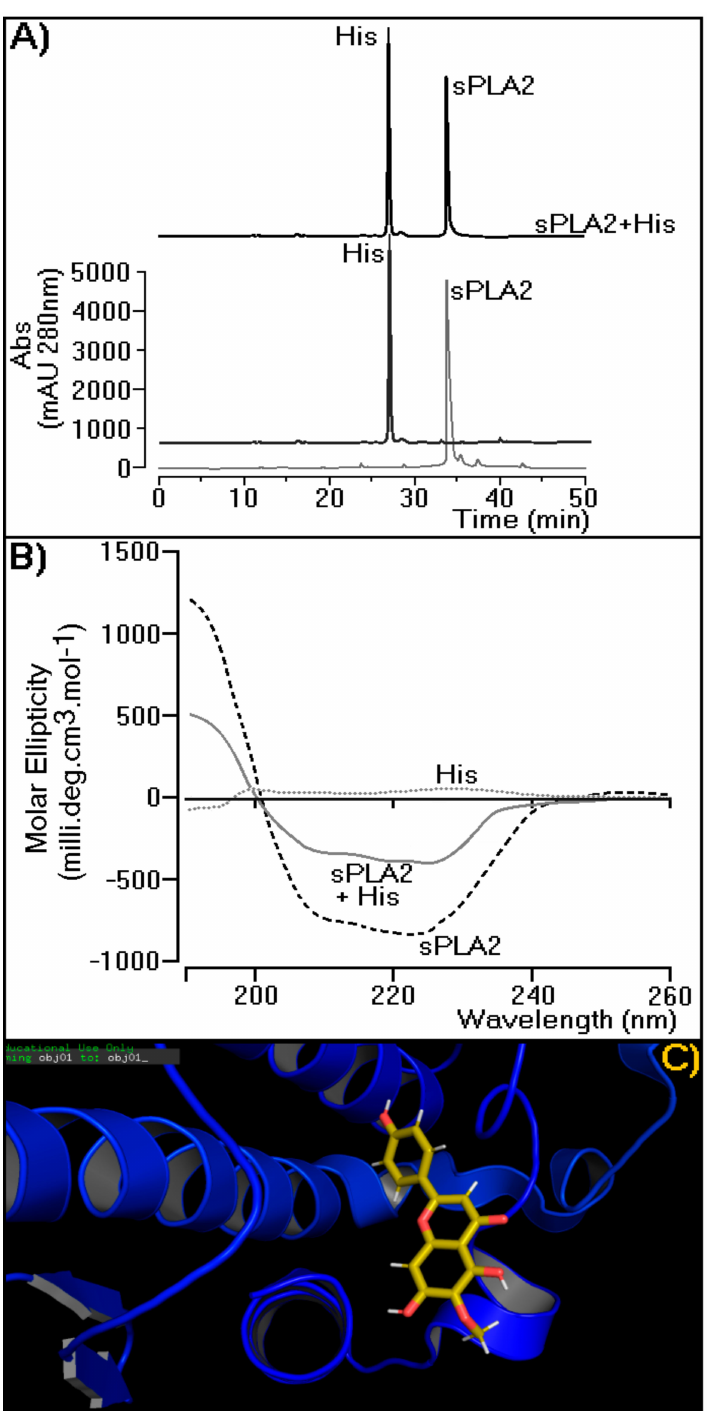
Figure 7. Characterization of possible molecular interaction of His with sPLA2 from Crotalus durissus terrificus. ( A ) Investigation of the His–Ctd sPLA2 using reverse-phase HPLC. ( B ) Circular dichroism (CD) spectral profile data were acquired over the range of 185–280nm. Ctd sPLA2 is represented by the gray line, Ctd sPLA2 + His by the dashed gray line, and His by the dotted gray line. The CD spectra are expressed in θ cm 2 / dmols. ( C ) Molecular modeling of hispidulin in the sPLA2 active site. The structure of Ctd SPLA2 is represented in dark blue (PDB: 2QOG) and the His molecule by sticks and lines with the atoms colored as follows: C, yellow; N, blue; O, red; and H, white